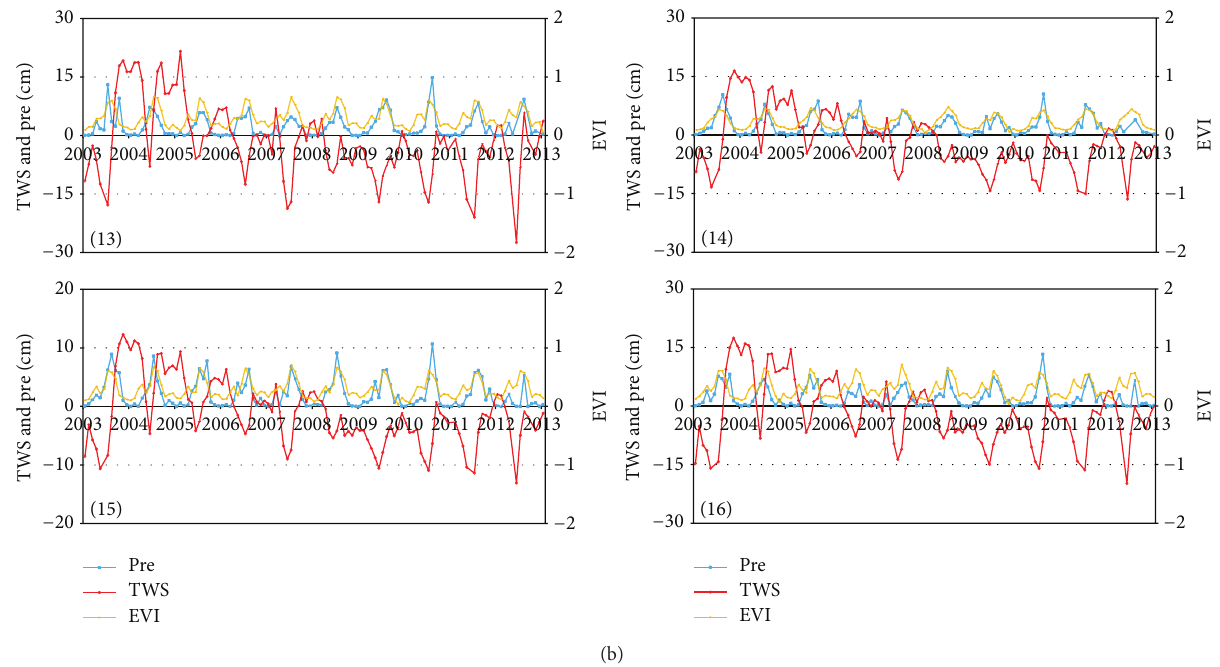
Figure 3: Time-series of TWS, precipitation, and the EVI of selected pixels (the unit of TWS change is cm; the unit of precipitation is 2 cm).